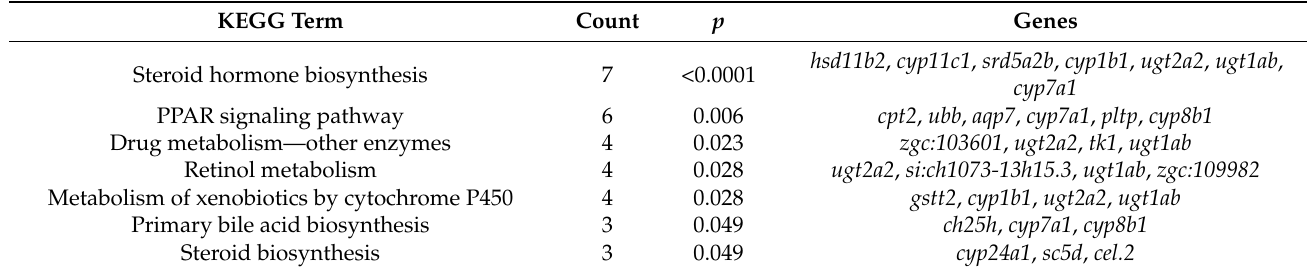
Table 1. KEGG analysis of DEGs in the cyp1b1 -KO zebrafish line using the DAVID bioinformatic tool. The count indicates the number of genes included in each